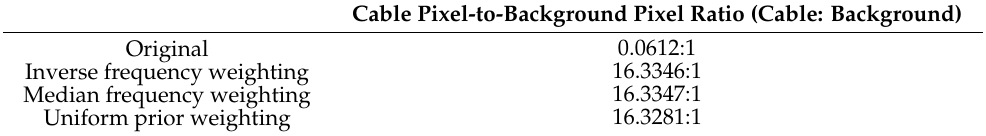
Table 6. Original cable pixel to background pixel ratio of training and validation images and that after weighting.